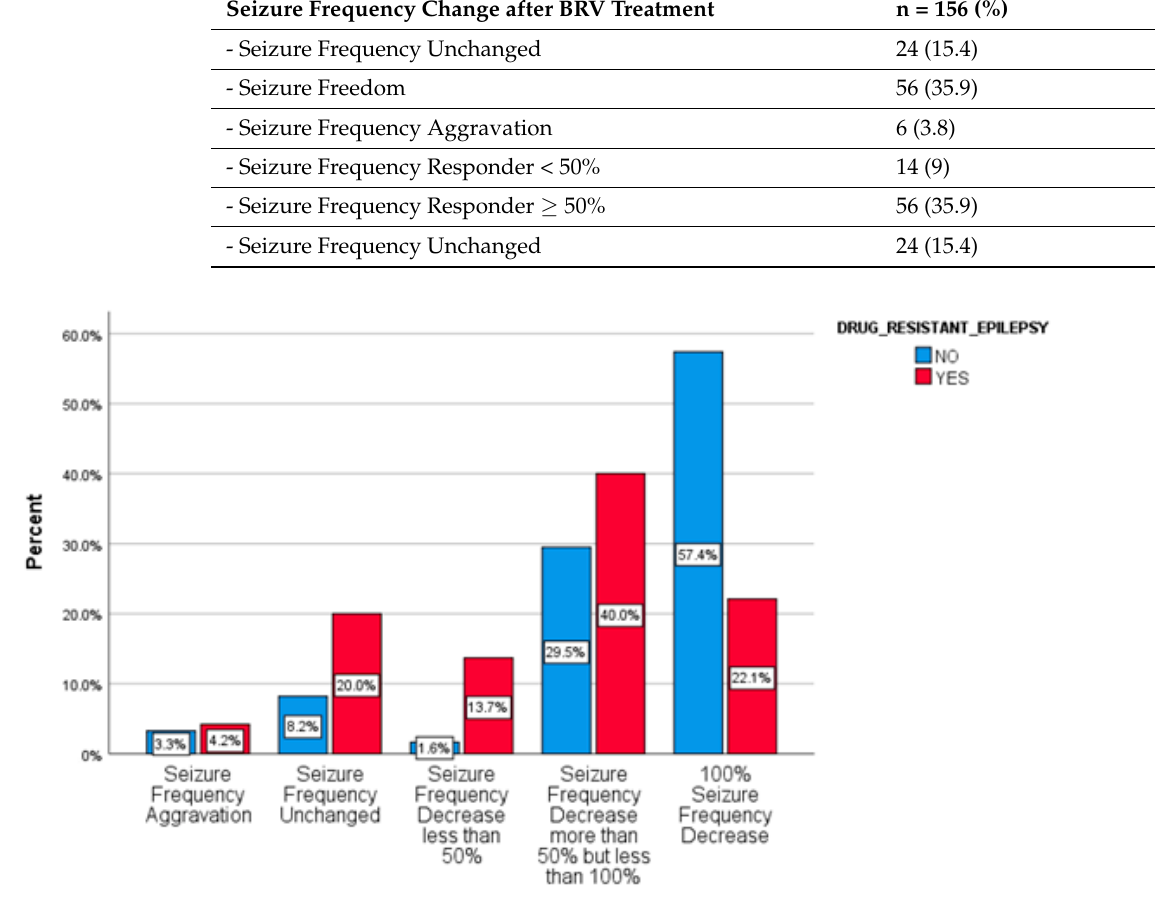
Figure 1. Response rates in drug-resistant epilepsy.